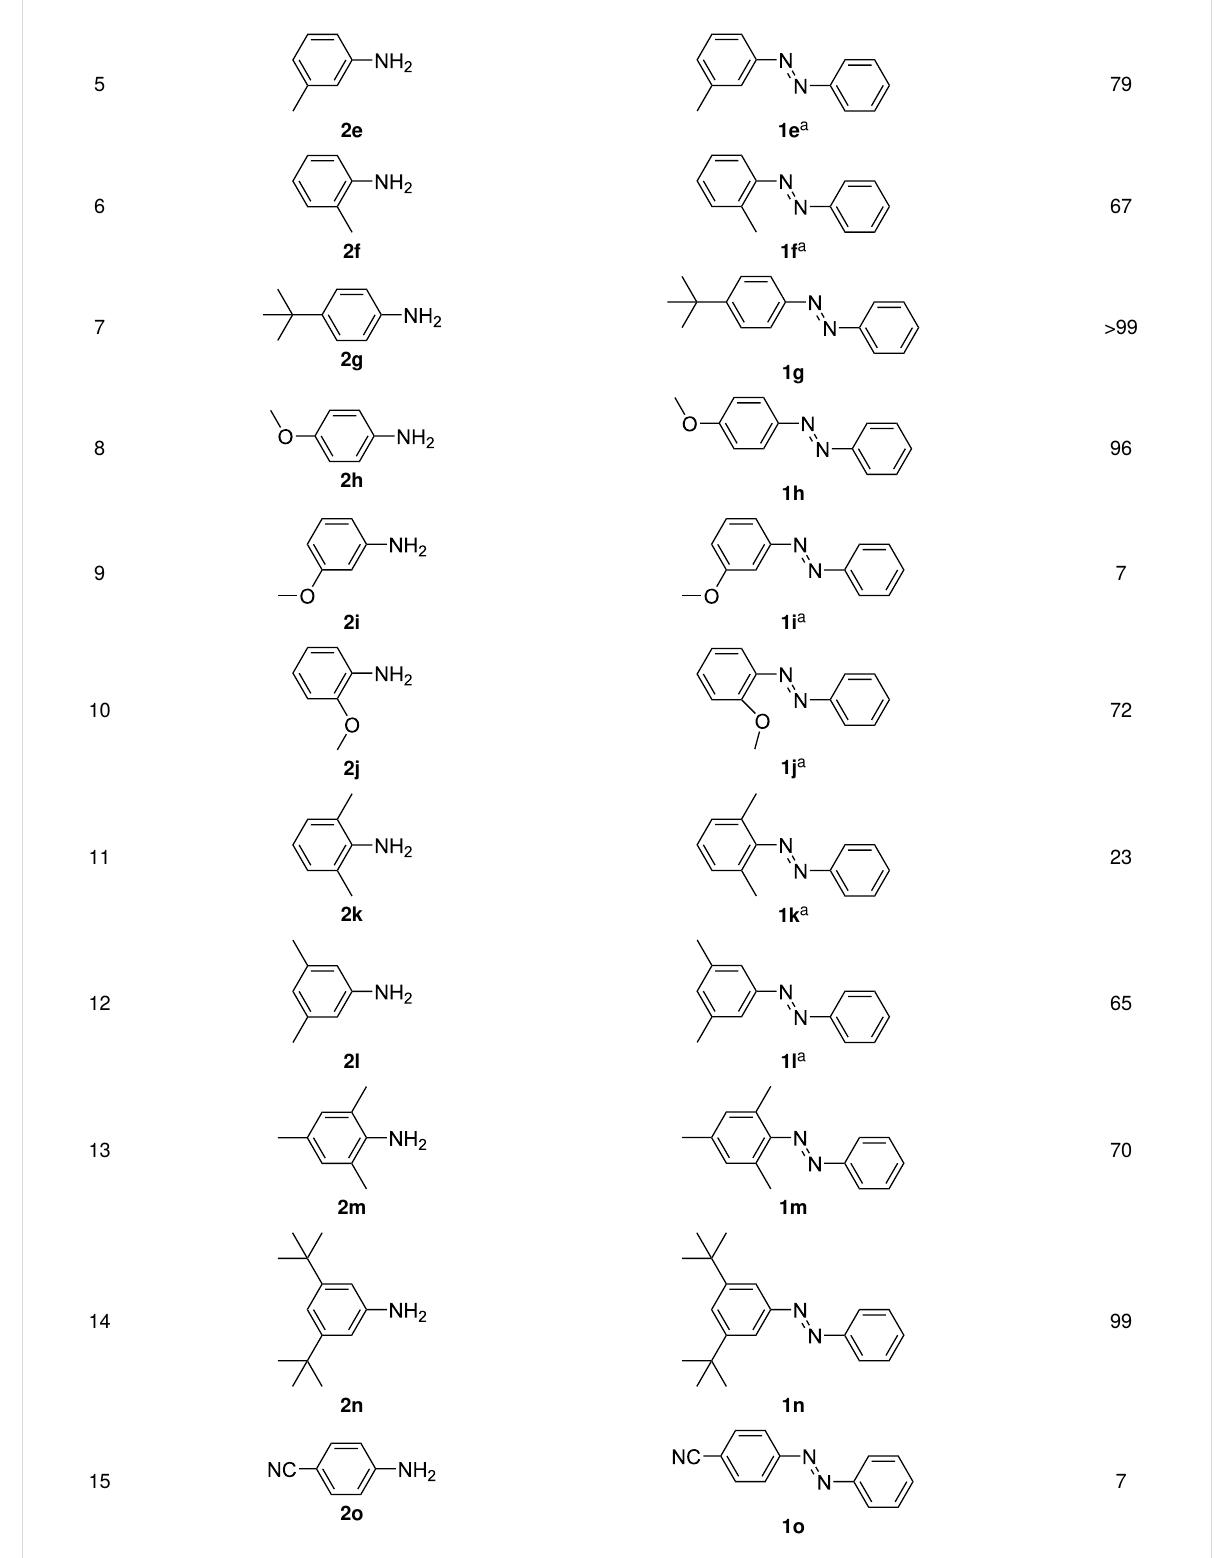
Table 1: Substrate scope of the Baeyer–Mills reaction under the optimized conditions in continuous flow.